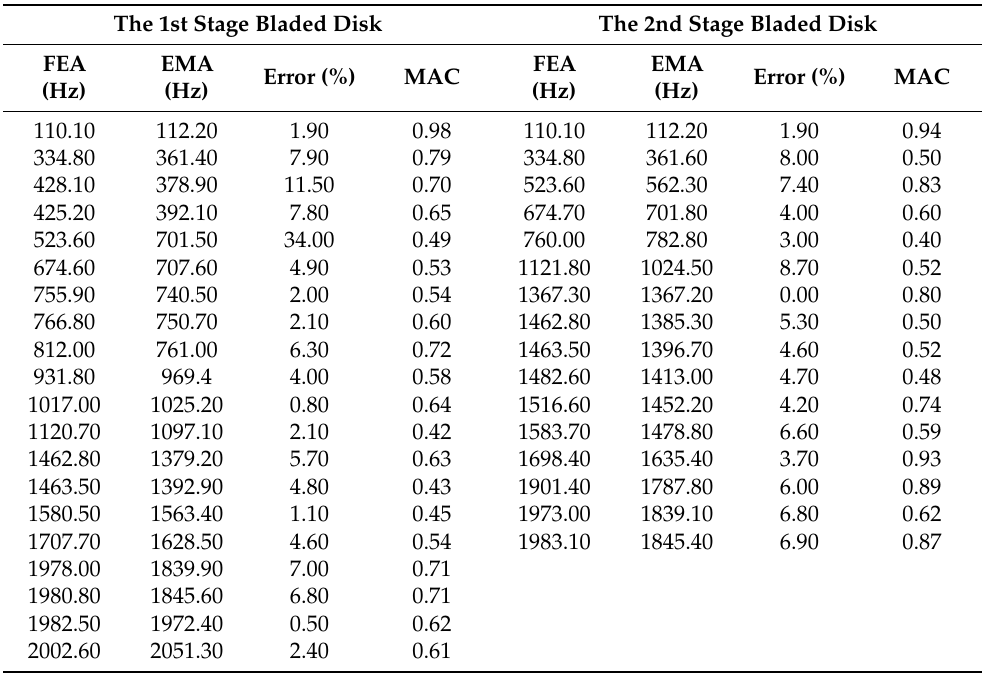
Table 3. Results of modal frequencies of the first and 2nd stage bladed disk.